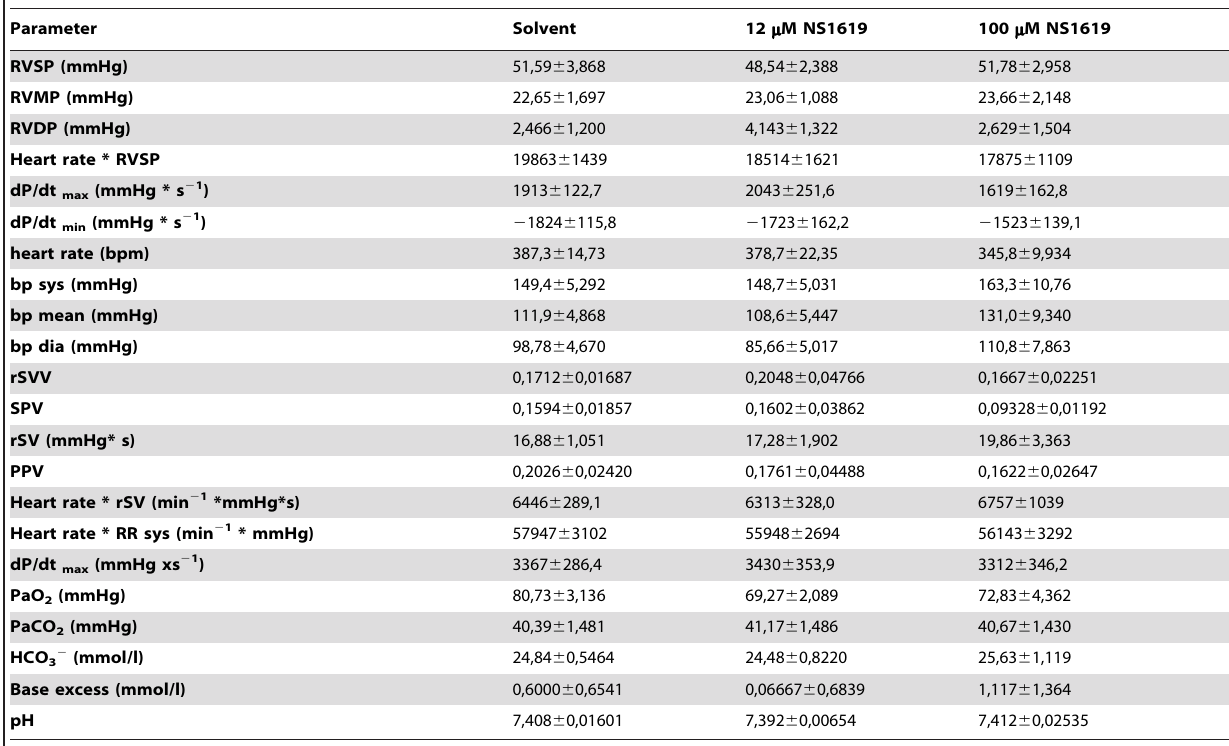
Table 1. Basic values.